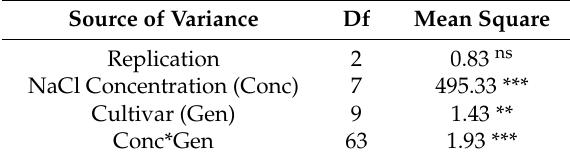
Figure 1. Preliminary salt treatment study determines the optimal salt stress conditions for Camelina sativa . ( a ) germination percentage of Camelina sativa cultivars seedlings under different NaCl salt concentrations; and ( b ) germination percentage of 10 C. sativa cultivars seedling under different NaCl salt concentrations. Note: letters “a” or “b” refer to significant difference levels. Table 1. Two-way Analysis of Variance (ANOVA) of germination percentage.